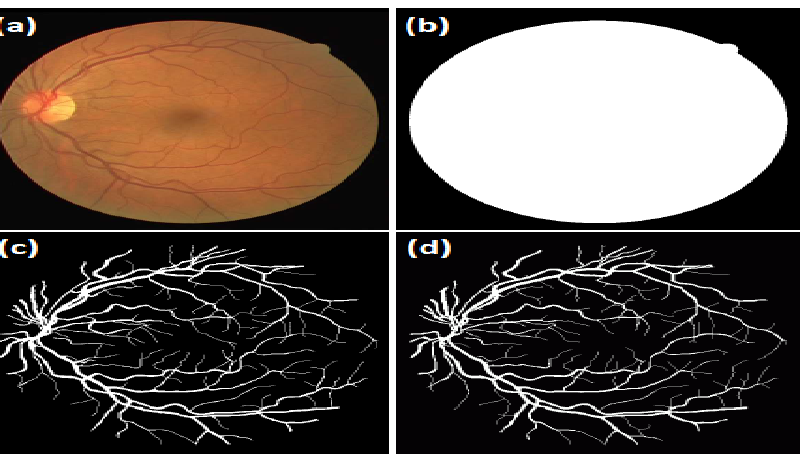
Figure 9. Image example from the DRIVE dataset: ( a ) the original image; ( b ) FOV-mask image; ( c ) the manually segmented image of the first expert; and ( d ) the manually segmented image of the second expert.